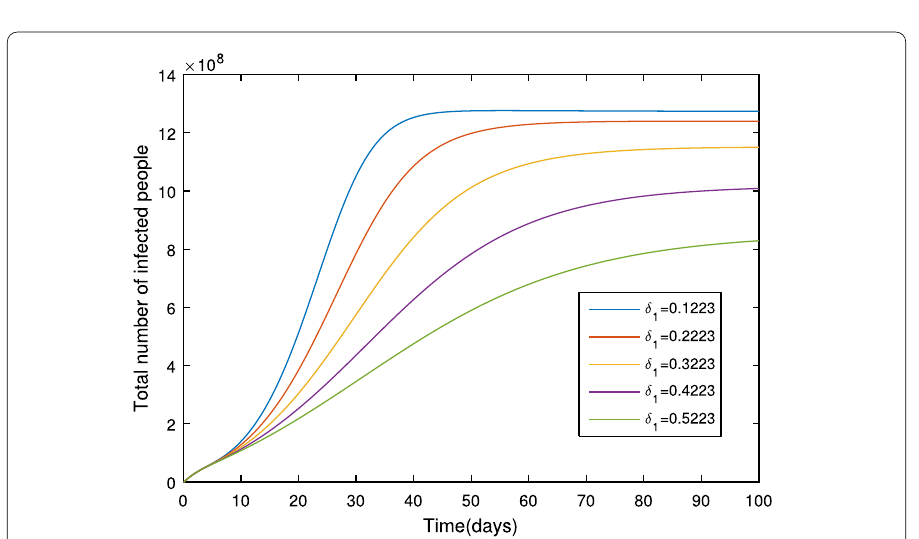
Figure 7 The total number of infected people for various values of δ 1